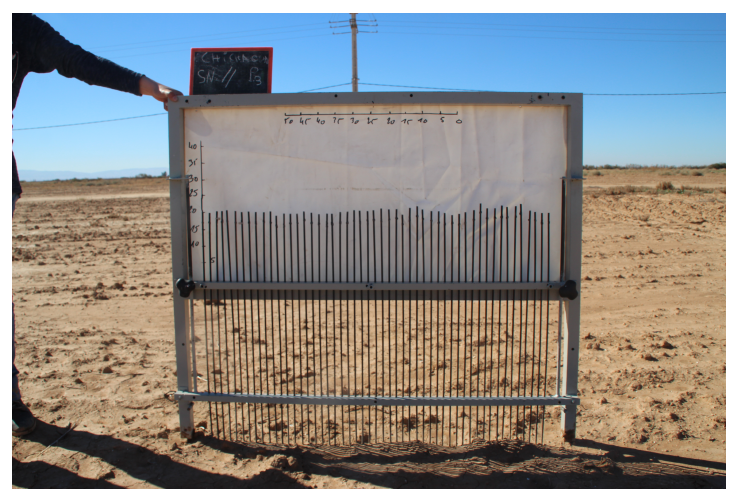
Figure 2. Example of the needle-profilometer used in this study. Table 1. Dates of the Sentinel-1 overpasses over our site during the study period. The Sentinel-1 images used for training or validation sets are also